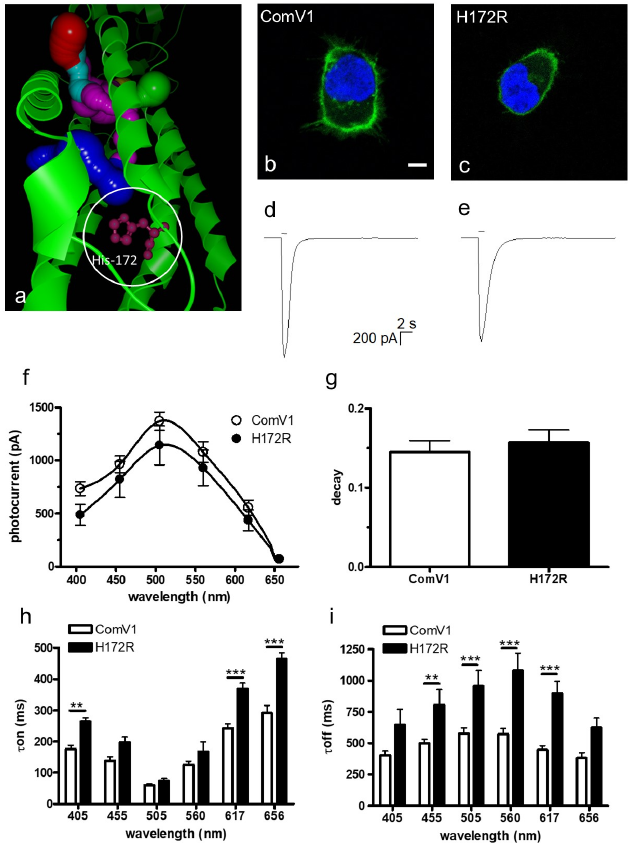
Figure 1. Comparison of functions between ComV1 and H172R. ( a ) The structure of ComV1 predicted using a bioinformatic tool. The protein is indicated by the green ribbon. H172 is located near the ion tunnel. ( b , c ) The fluorescence of 4 ′ ,6-diamidino-2-phenylindole (DAPI) (blue) and ComV1- Venus or H172R-Venus (green) introduced into HEK293 cells. The scale bar indicates 5 µm. Both genes are mainly expressed on the plasma membrane. ( d , e ) The typical waveforms of ComV1 ( d ) and H172R ( e ) were evoked with a 505-nm light-emitting diode adjusted to 1 µW/mm 2 for 1 s. ( f – i ) Comparison of photocurrents ( f ), decays at 505 nm ( g ) , τon ( h ) , and τoff ( i ) between ComV1 and H172R. Data are expressed as mean ± standard error of mean (SEM) (ComV1 n = 18–19, H172R n = 8). The data were compared using two-way analysis of variance (ANOVA) with Bonferroni post-test (** p < 0.01, *** p < 0.001).